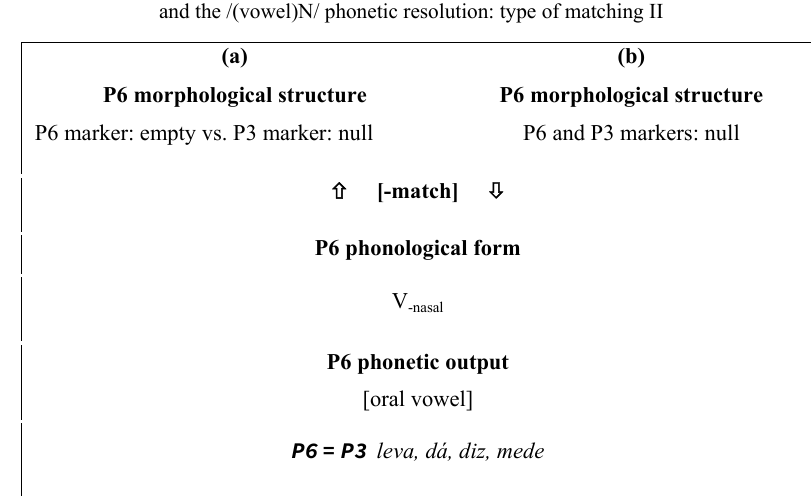
Table 4 – The matching between the P6 morphological and phonological structure, and the /(vowel)N/ phonetic resolution: type of matching